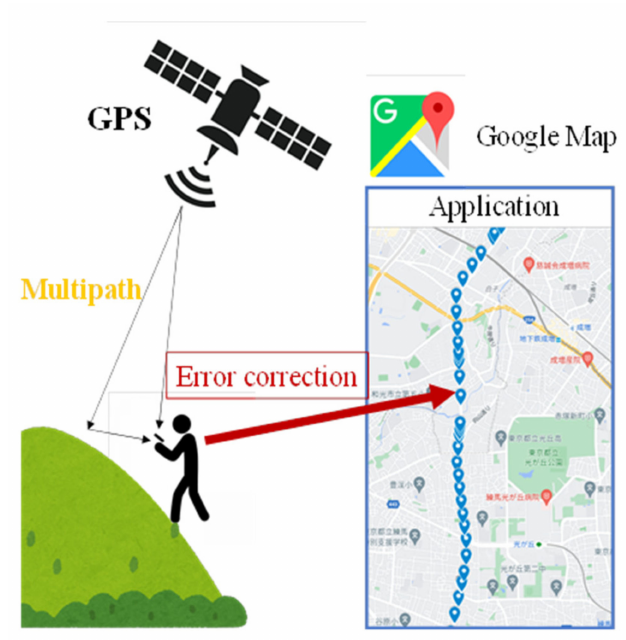
Figure 2. The outline of this study.